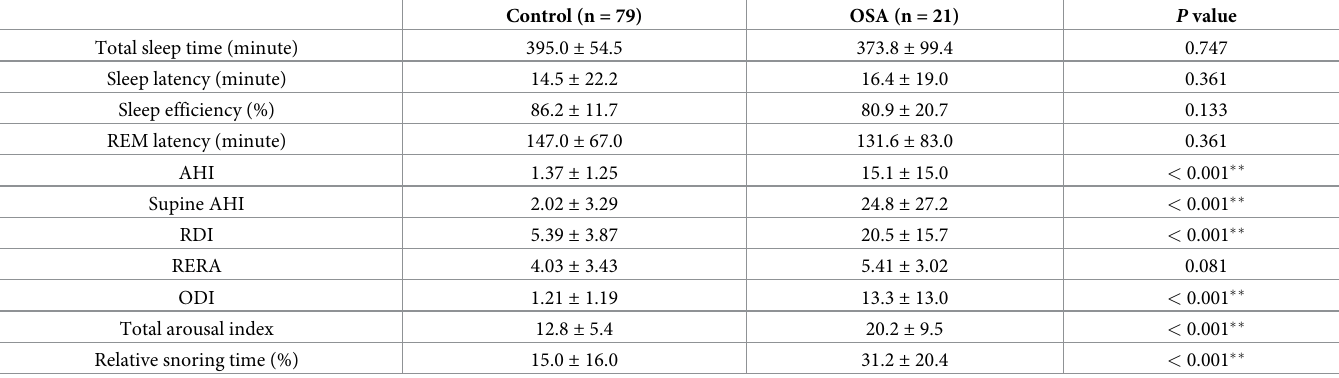
Table 2. Polysomnography results of the